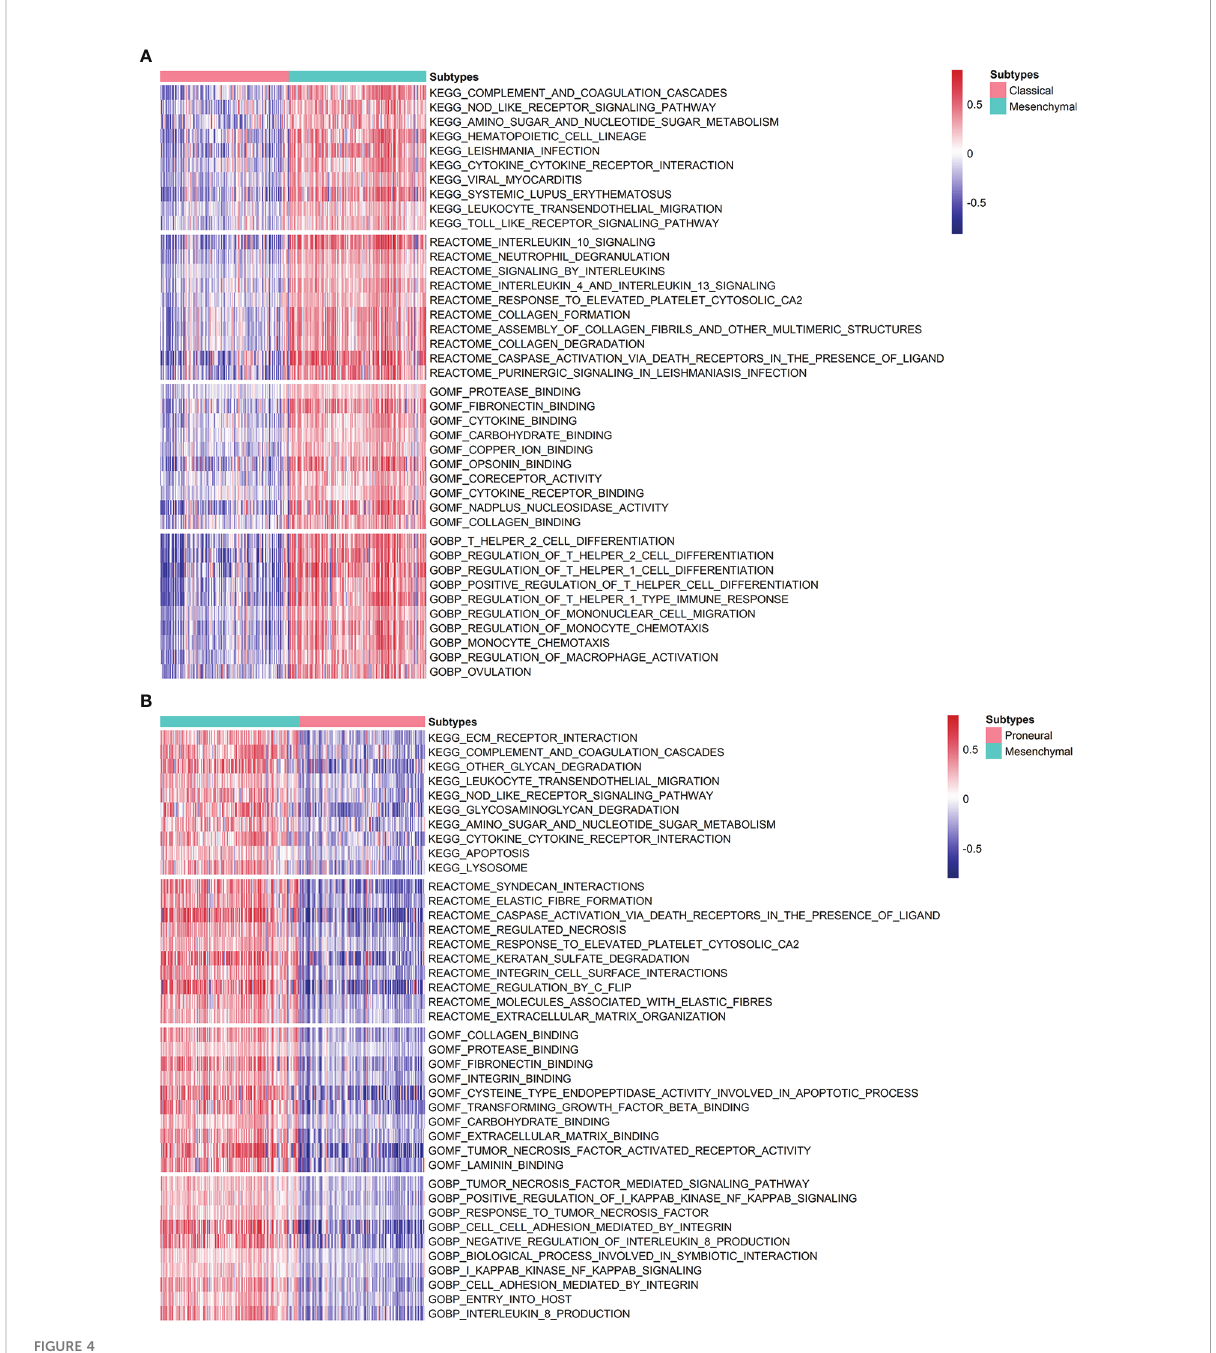
FIGURE 4 Analysis of the differences in the enrichment scores of KEGG pathways, Reactome categories, and GO terms demonstrated by GSVA among GBM subtypes. (A) Heatmap describing the top 10 signi fi cantly differential signatures, including KEGG pathways, Reactome, and GO terms between MES and CL. (B) Variants in KEGG pathways, Reactome categories, and GO terms between MES and